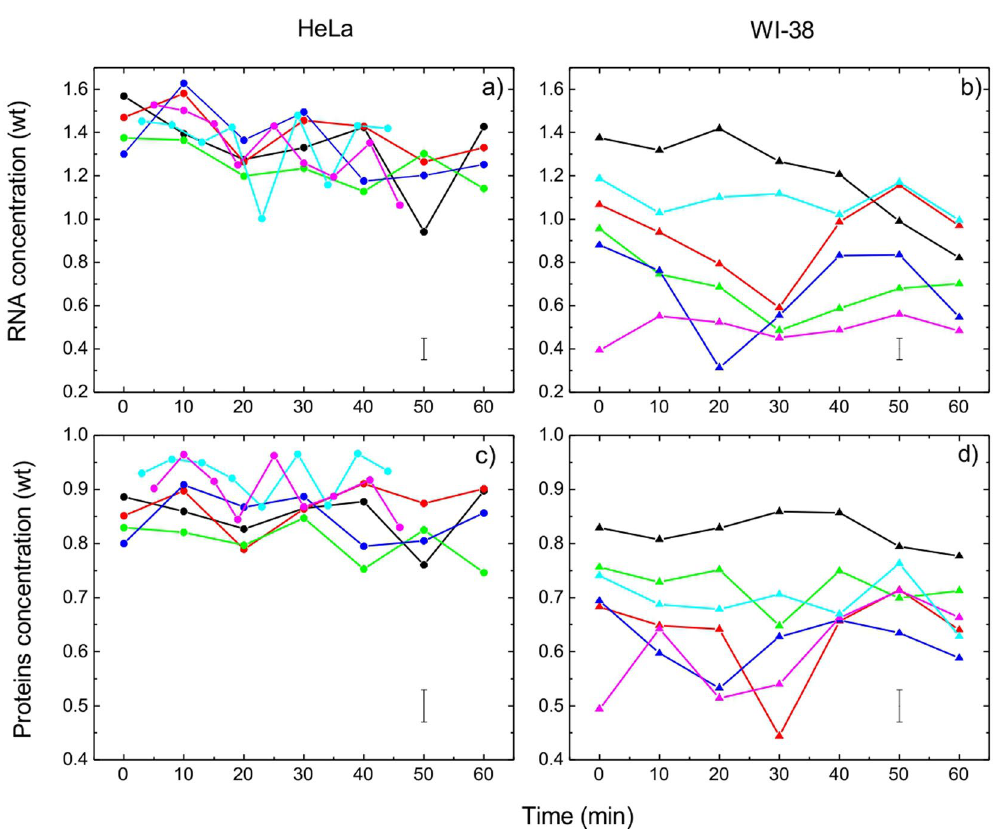
Figure 5. Dynamics behavior of RNA ( a , b ) and proteins ( c , d ) concentrations in 6 single nucleolus of HeLa ( a , c ) and (WI-38 ( b , d ) cells. Standard deviatios are shown as error bars in lower sector of each graph. Concentration weight unit corresponds to 100 mg/ml for proteins and 20 mg/ml for